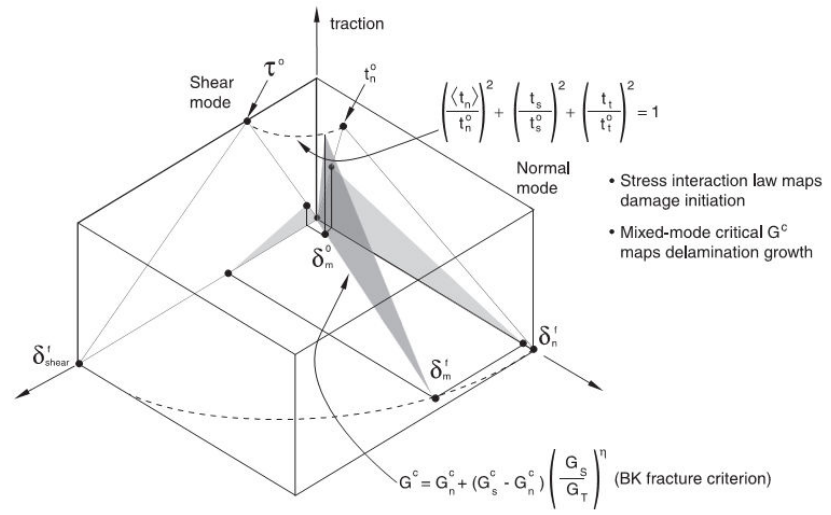
Figure 7. Viscous contact progressive damage behavior of the secondary stress separation criterion. Table 2. Contact parameters.